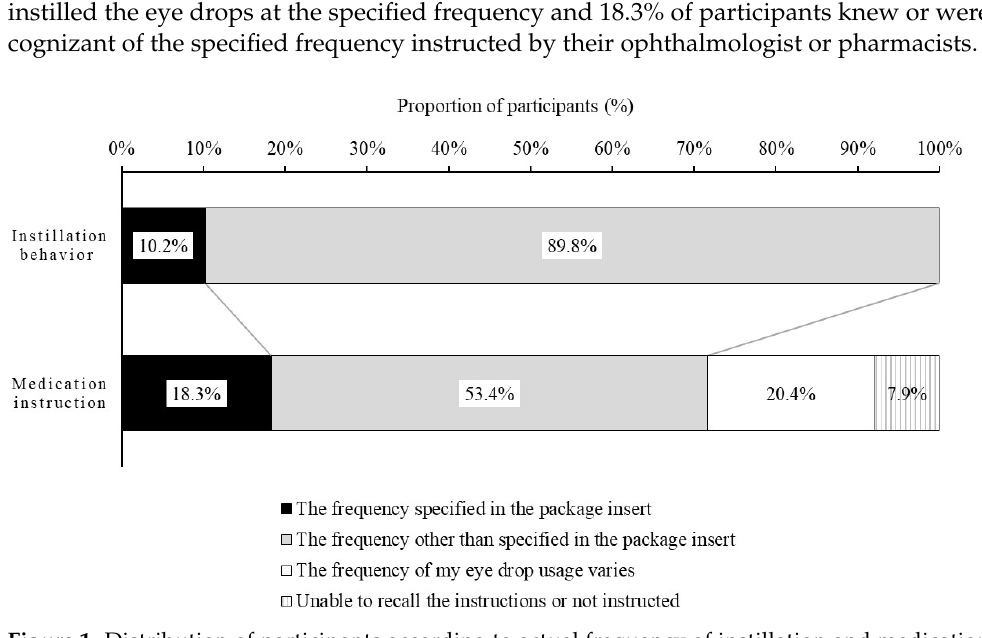
Figure 1. Distribution of participants according to actual frequency of instillation and medication instruction knowledge status. The frequency specified in the package insert for each DED eye drop was as follows: DQS, 6 times per day; HA, 5 to 6 times per day; RBM, 4 times per day. DQS: 3% diquafosol sodium ophthalmic solution; HA: sodium hyaluronate ophthalmic solution; RBM: 2% rebamipide ophthalmic suspension; DED: dry eye disease. The distribution of participants according to the actual frequency of instillation for the three types of DED eye drops is shown in Figure S1 and the distribution of participants according to medication instruction knowledge status for the three types of DED eye drops is shown in Table S3. The proportion of participants who actually instilled the DED eye drops at the specified frequency (4 times per day) was high (13.7%) for those instilling RBM and low for those instilling HA and DQS. On the other hand, the proportion of par- ticipants who answered “at the specified frequency instructed by their ophthalmologist or pharmacists,” was the highest for RBM (28.8%), but patients in the HA group were less likely to know the specified frequency than patients in the DQS group. 3.3. Reasons Why Participants Did Not Instill the Eye Drops at the Frequency Instructed by Ophthalmologists or Pharmacists Figure 2 shows the proportions of participants grouped by their reasons for not fol- lowing medication instructions. These data were from the 2108 participants (79.7%) who had answered that there was at least one day when DED eye drops were not used at the specified frequency. Participants “agreed” or “strongly agreed” with the following rea- sons: R1 (Because I used the eye drops after feeling symptoms such as dryness in my eyes.), R2 (Because I forgot to carry my eye drops with me when I went out, or because it’s bothersome to carry it around.), R3 (Because the symptoms were relieved with the eye drop treatment, I did not need to use the eye drops.), R4 (Because the frequency of use instructed by the ophthalmologist or pharmacist was high.), and R5 (Because unit dose bottles are too bulky to carry around.). There was no difference in the proportions of pa- tients by reason for not following medication instructions among the three groups cate- gorized by eye drop type (Figure S2). Among participants who received instruction from ophthalmologists or pharmacists, the reasons given for not following instructions in the order of highest to lowest proportion of participants was R1, R2, R4, R3, and R5. In this population, the frequency of the R4 response was higher (Figure S3).